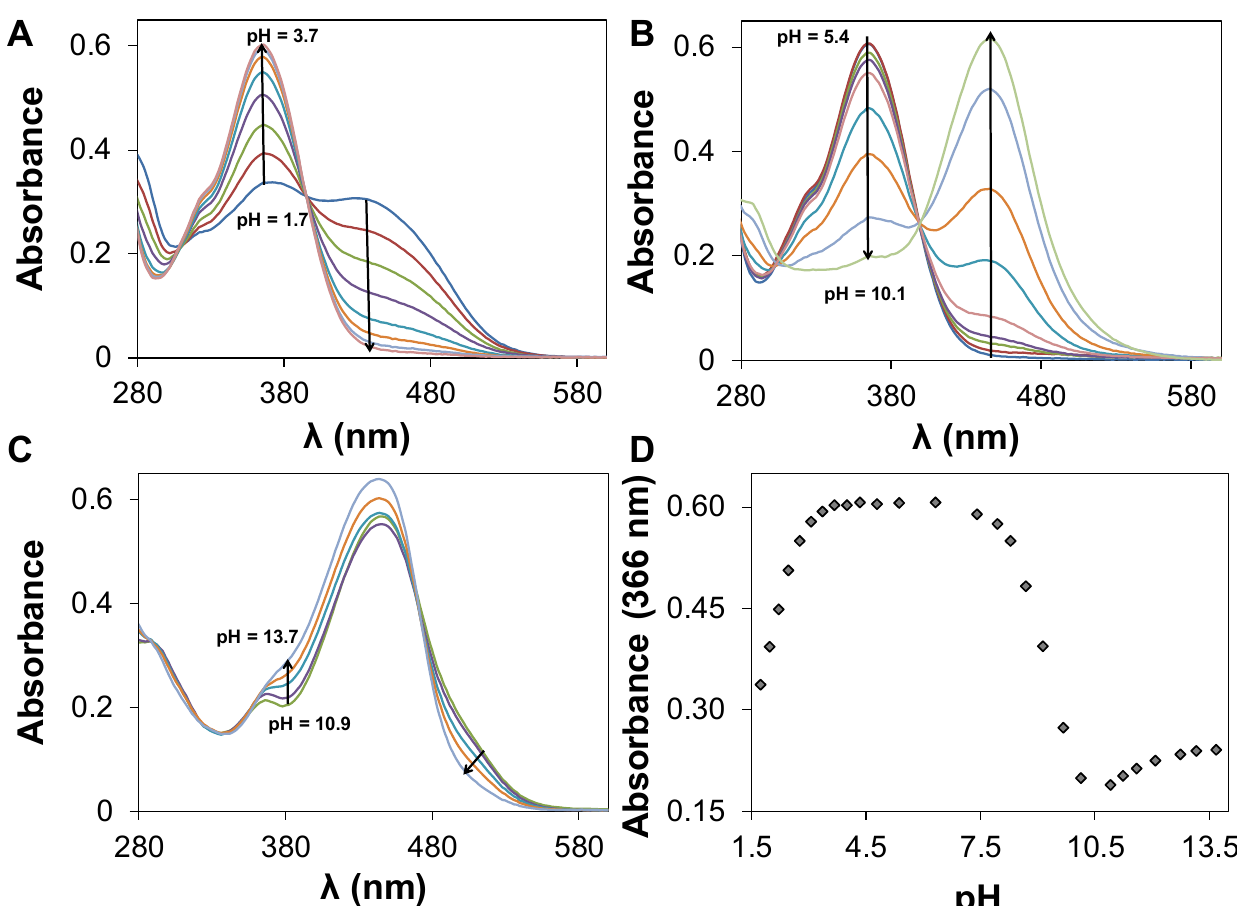
Figure 7. UV-vis spectra of the ligand recorded at various pH values in 60% ( v / v ) DMSO/H 2 O mixture, showing: ( A ) the first deprotonation step; ( B ) the second deprotonation step; ( C ) the third deprotonation step. ( D ) Absorbance changes at 366 nm as a function of pH, showing all visible deprotonation steps of the ligand in 60% ( v / v ) DMSO/H 2 O mixture. [ c ligand = 4.86 μ M; I = 0.10 M (KCl); ℓ = 5 cm; T = 25.0 °C].